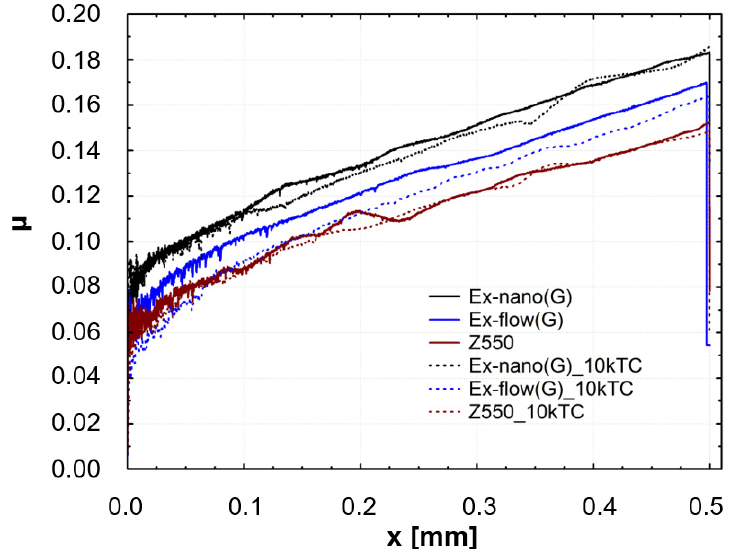
Figure 5. Mean curves of the coefficient of friction ( μ ) as a function of the indenter position (x).